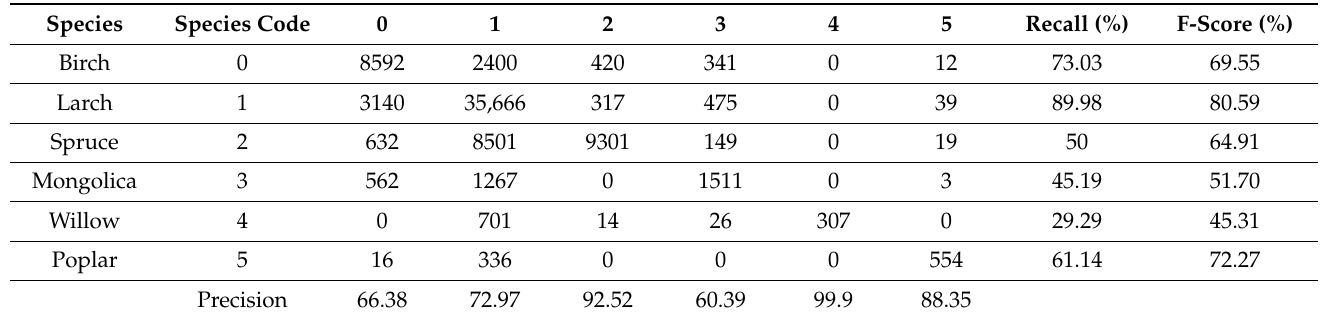
Table 6. The tree classification confusion matrix for tree species classification using ground truth (rows) compared to the DBMA model species prediction (columns; numbered labels refer to species numbers shown in row labels).